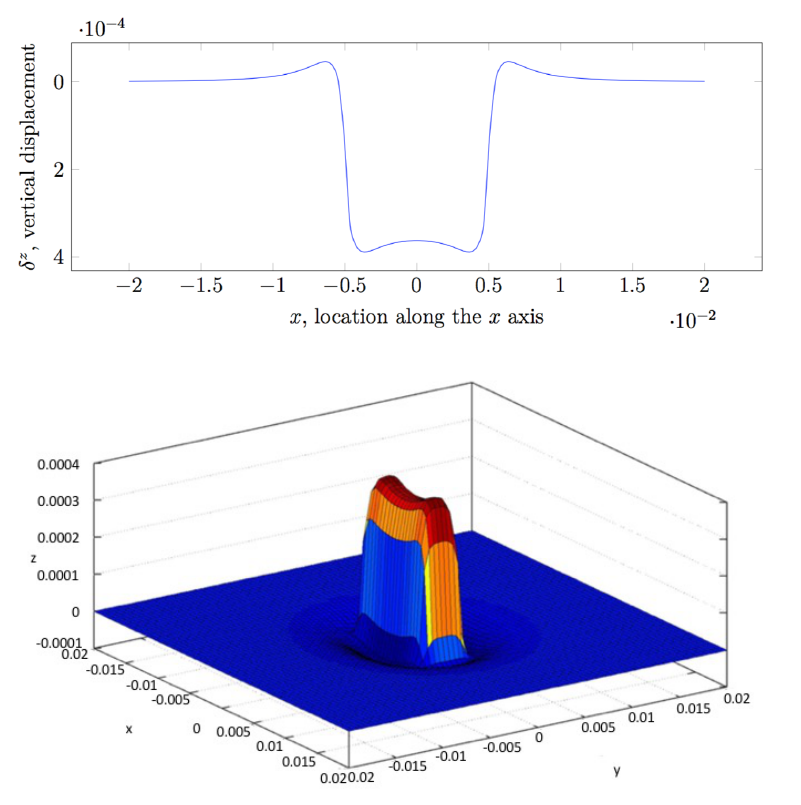
Figure 5. Love’s solution for a uniform pressure p = 1 × 10 5 Pa over a cell of 10 × 4 mm size, with E = 2.1 × 10 5 Pa, h n = 2 mm, shown along y = 0 ( top ), and the corresponding 3 D view of the Love’s solution ( bottom